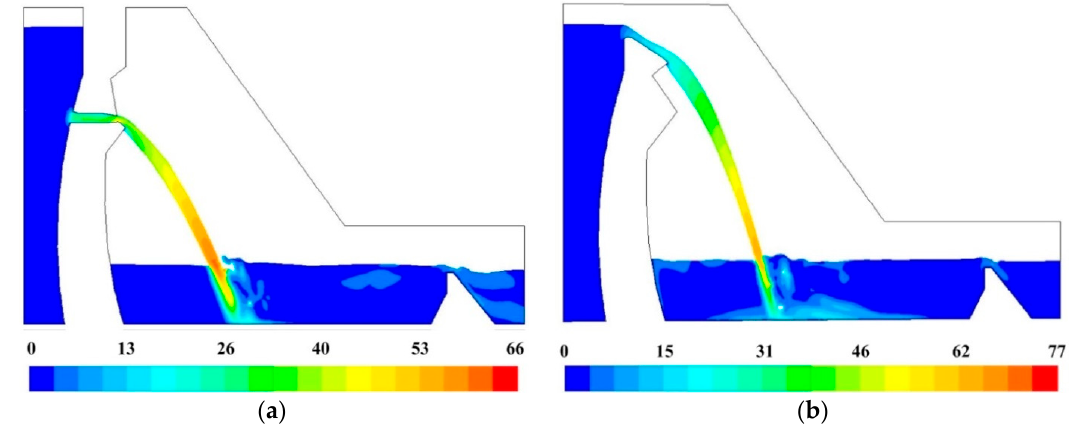
Figure 10. Vorticity contours in energy dissipation area (the unit is s − 1 ): ( a ) Condition 2; ( b ) Condition 6.